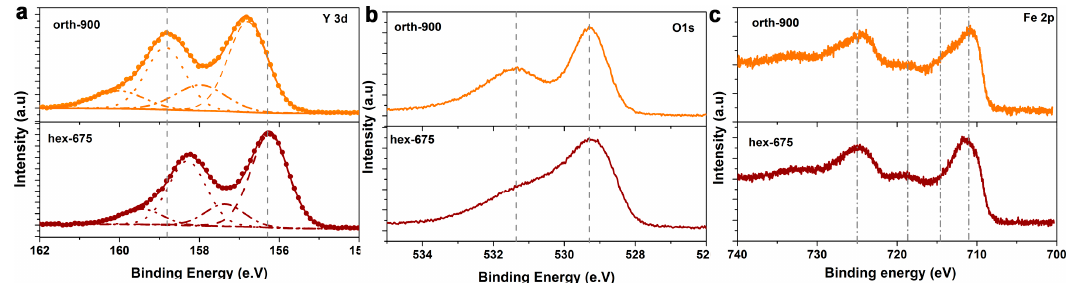
Catalysts 2017 , 7 , 326 5 of 14 Figure 3. ( a ) Kubelka ‐ Munk function (F(R)) vs. wavelength, showing the absorption onsets. The insets show the colors of the YFeO 3 powders ( b ) Tauc plots for indirect band gap determination of the YFeO 3 samples. In Figure 3b the Tauc plots obtained from the absorption data by plotting of ( F ( R )*h ν ) 1/2 versus